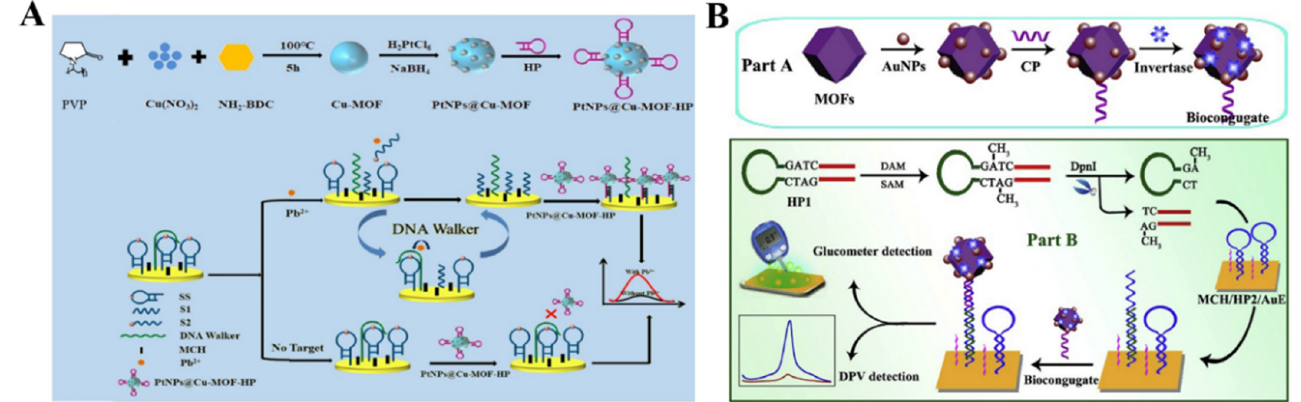
Figure 12. ( A ) Schematic illustration of the fabrication of PtNPs@Cu − MOF − HP/Pb 2+ /MCH/DNA walker-SS/AuE sensor and the mechanism of Pb 2+ detection. Reprinted with permission from Ref.